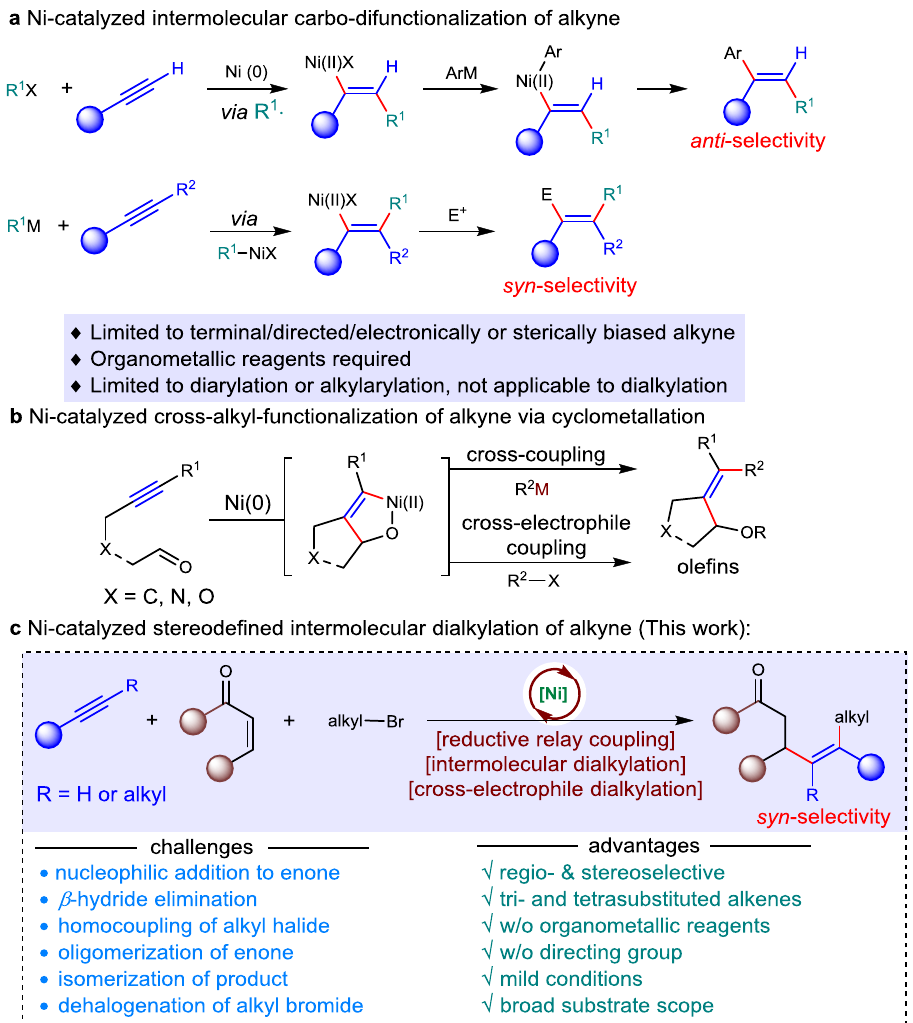
Fig. 1 Stereode fi ned access to multiple alkylated alkenes. a Ni-catalyzed intermolecular carbo-difunctionalization of alkyne. b Ni-catalyzed cross-alkyl- functionalization of alkyne via cyclometalation. c Ni-catalyzed stereode fi ned intermolecular dialkylation of